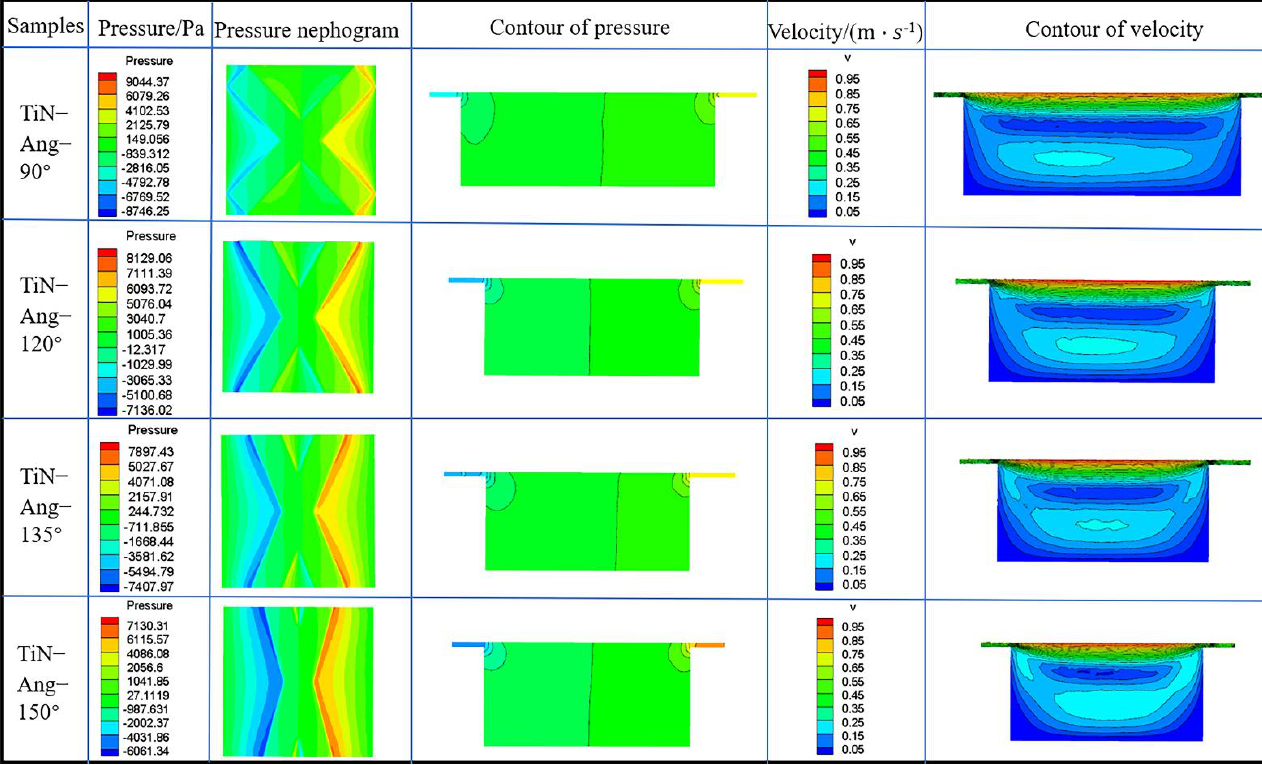
Figure 7. Simulation results with different groove angles.